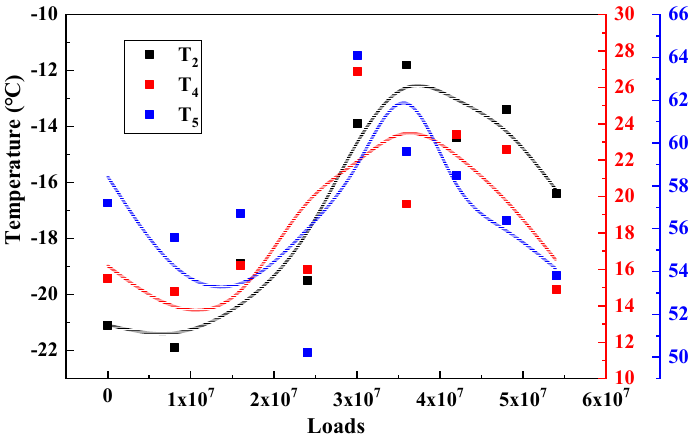
Figure 9. Characteristic temperature variation of STR1/3.